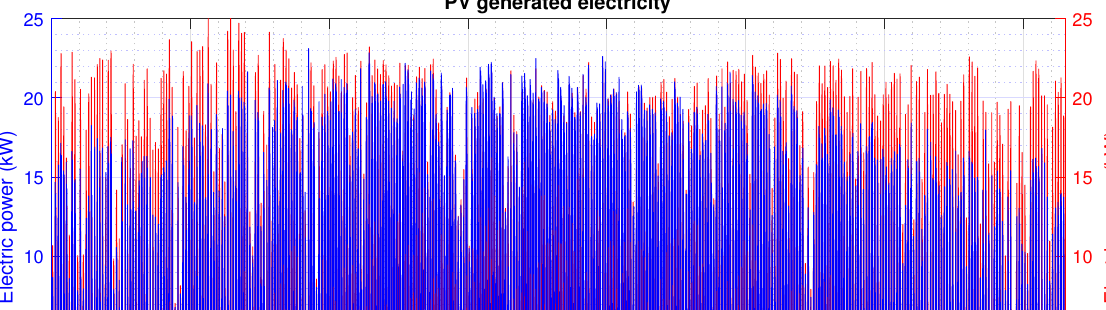
Figure 12. Thermal power of the collector.